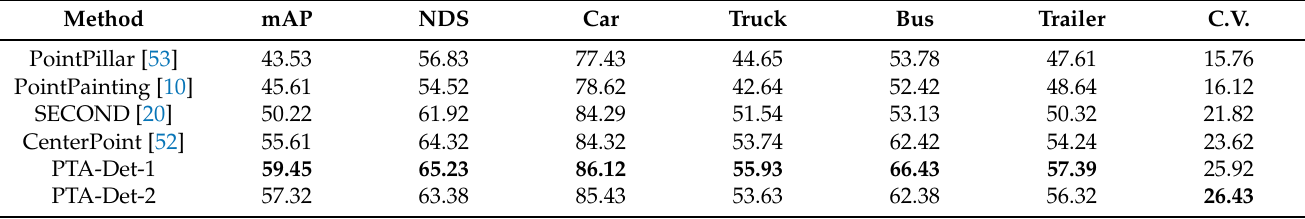
Figure 8. Visualized results by PTA-Det on KITTI test set. Green/turquoise/yellow bounding box indicates car/pedestrian/cyclist category, respectively. The scenes are arranged from left to right. The first and fourth show that PTA-Det performs well against distant objects. The second successfully detects all cars and excludes the object of van category. From the third scene, we observe that PTA-Det performs a little worse with multiple pedestrians and overlooks a car due to occlusion. Table 4. Comparison of previous baseline works on the nuScenes validation set. None of the methods in the table use data augmentation techniques and all take the same point cloud input as our model. C.V. is the abbreviation of construction vehicle. mAP, NDS scores, and APs are reported for vehicle-related categories. The optimal results are highlighted in bold